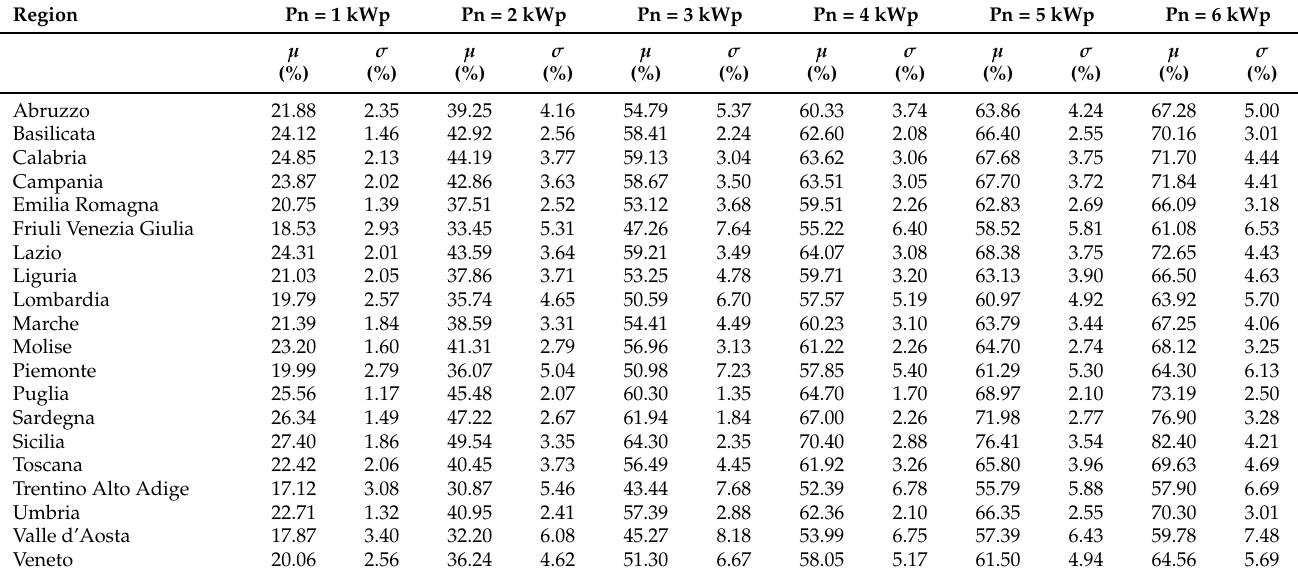
Table 27. Cost saving for E L = 4000 kWh with